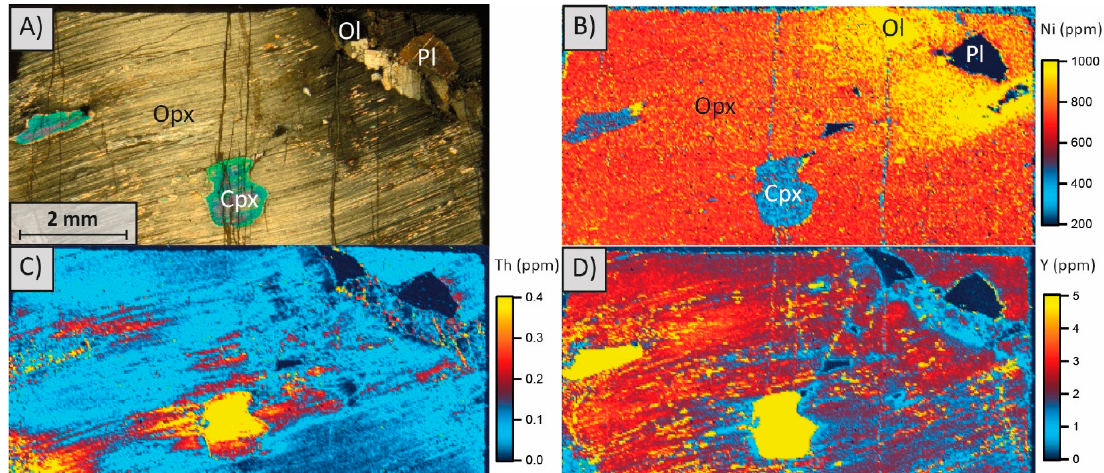
Figure 13. ( A ) Plane polarised photomicrograph of sample 308.90, Upper Distal; Pl (plagioclase), Opx (orthopyroxene); ( B ) Semi-quantitative Cr distribution map; ( C ) Semi-quantitative V distribution map; ( D ) Semi-quantitative Ni distribution map; ( E ) Semi-quantitative Y distribution map; ( F ) Semi- quantitative Th distribution map; With the exception of Ni, zonation patterns are present in all trace element distribution maps.